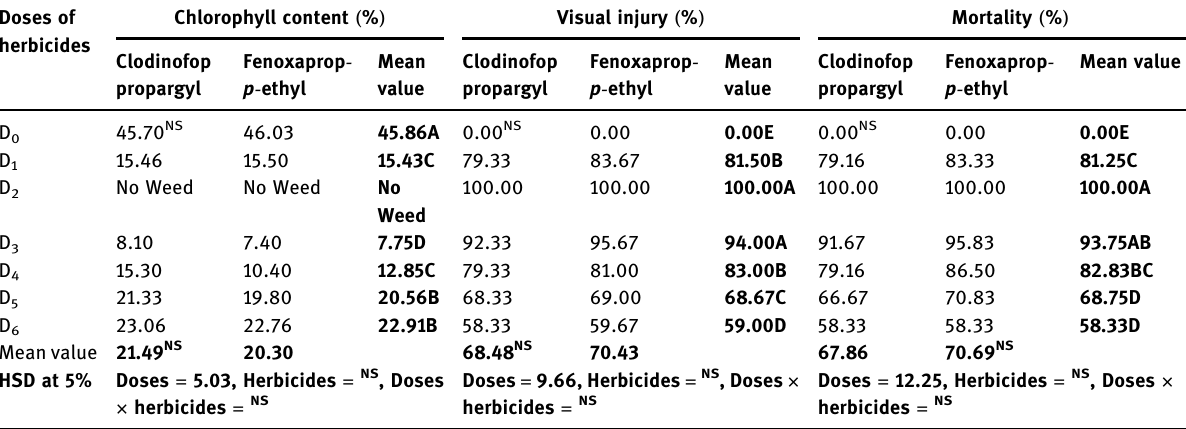
Chlorophyll content ( %